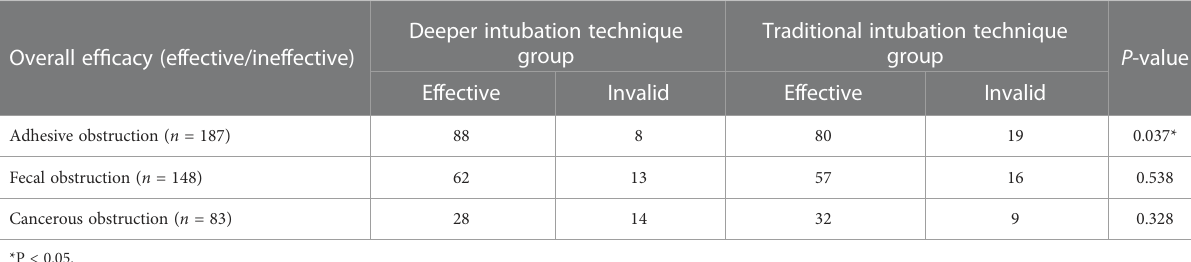
TABLE 4 Therapeutic ef fi cacies for different types of intestinal